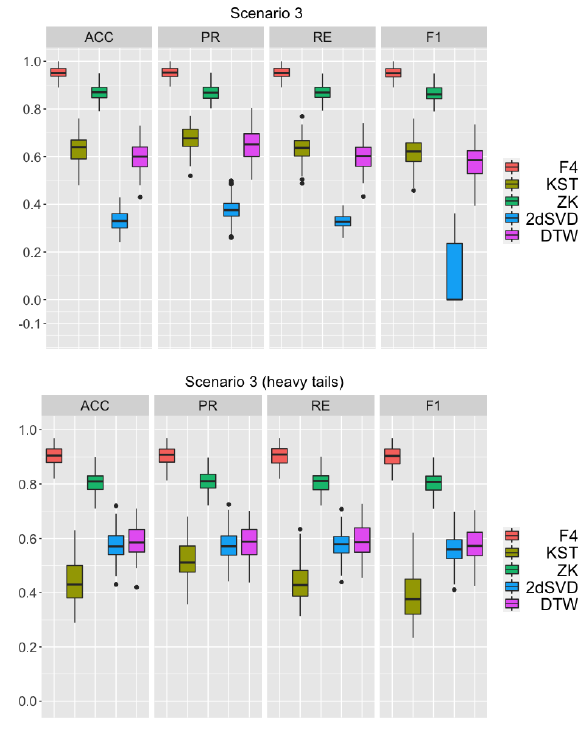
Figure 4. Boxplots of accuracy, precision, recall and F1-score based on 100 trials of the simulation procedure for Scenario 3 (top panel) and for Scenario 3 with heavy tails (bottom panel). Table 4. Averages and standard deviations (in brackets) of the performance metrics for the five classifiers in Scenarios 1, 2 and 3 with heavy tails. For each scenario and metric, the best average result is shown in